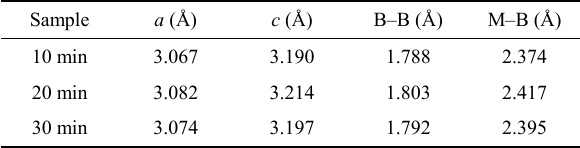
Table 3 Unit cell parameters and bond lengths of the as-synthesized HEB-1 products at 1423 K for different holding time by XRD